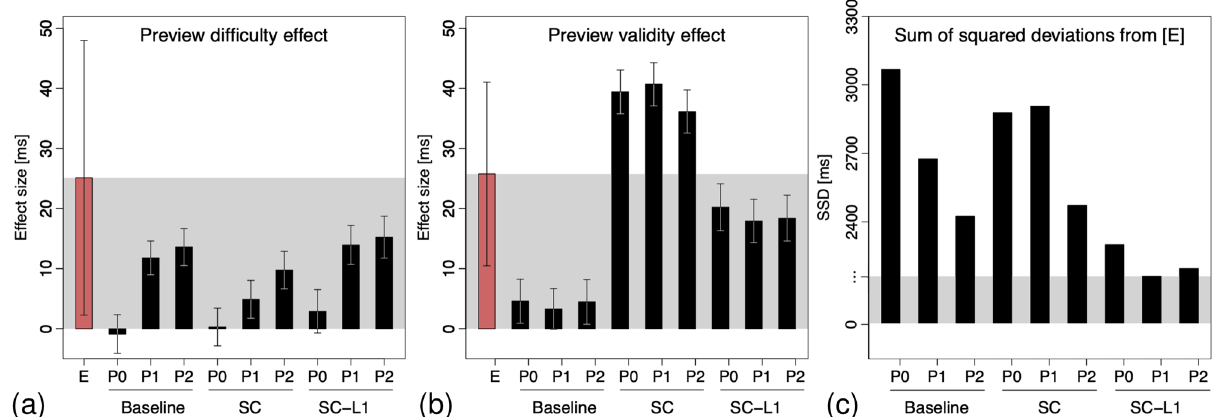
Figure 4. Predicted parafoveal preview effects for the first fixation after the boundary. ( a ) Preview difficulty effect. Smallest difference to experimental effects is observed for baseline models P1/P2 and SC-L1 model P1/P2. ( b ) Preview validity effect. Smallest difference from experimental effects obtained for SC-L1 models. ( c ) Overall model scoring. The mean sums of squared deviations from experimental effect sizes indicate best performances for models that combine parafoveal inhibition with processing dependent saccade